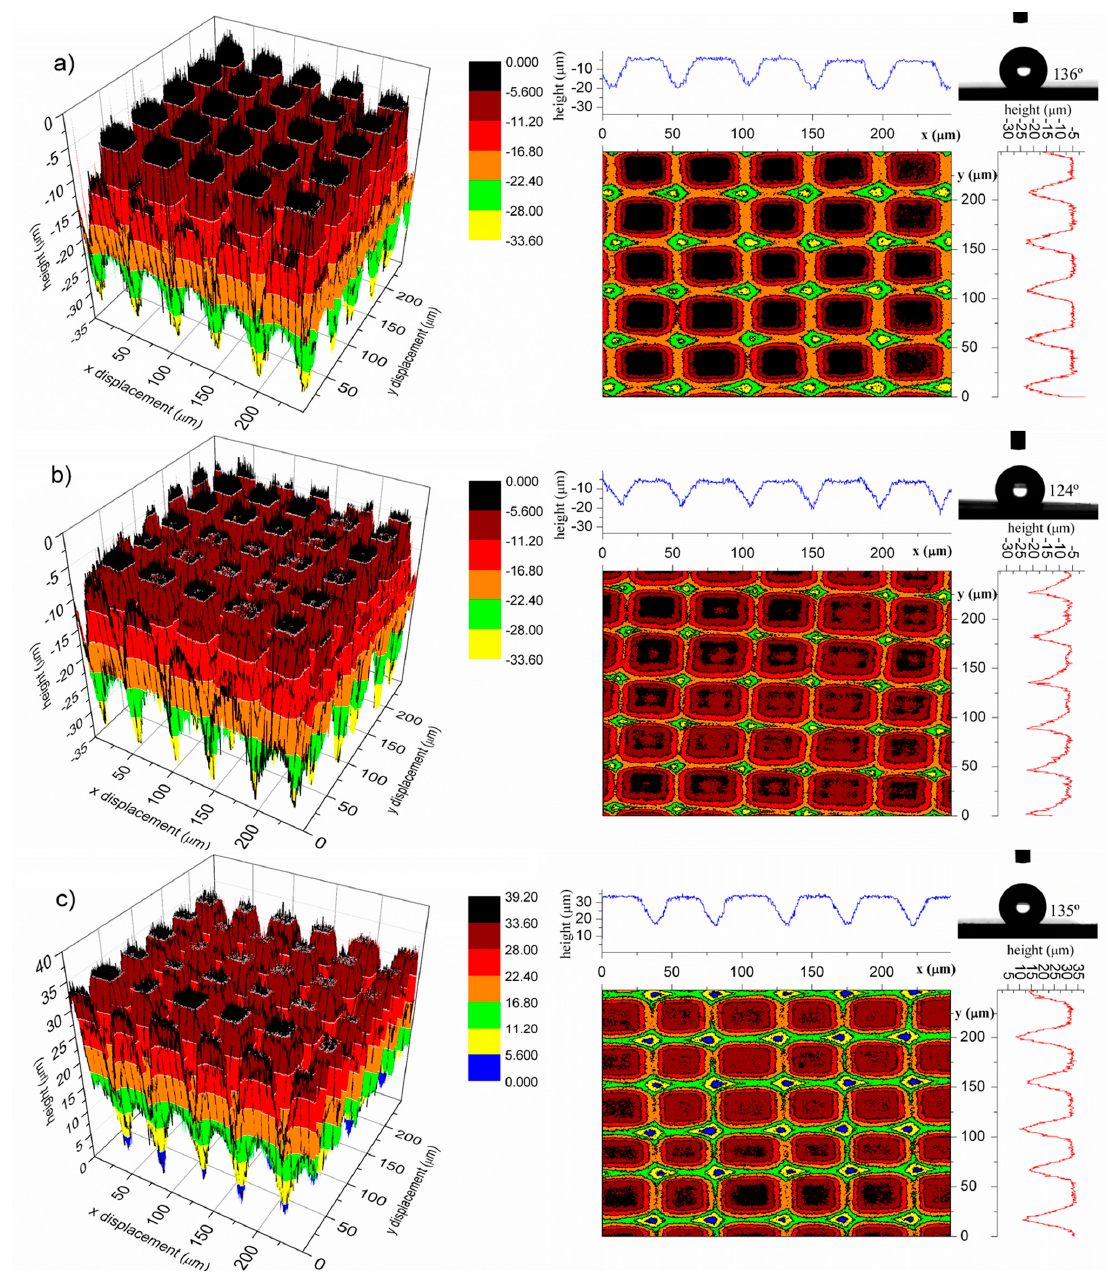
Figure 9. Topography and water contact angle for the first shape memory cycle: ( a ) original; ( b ) deformed (temporal shape); and ( c )